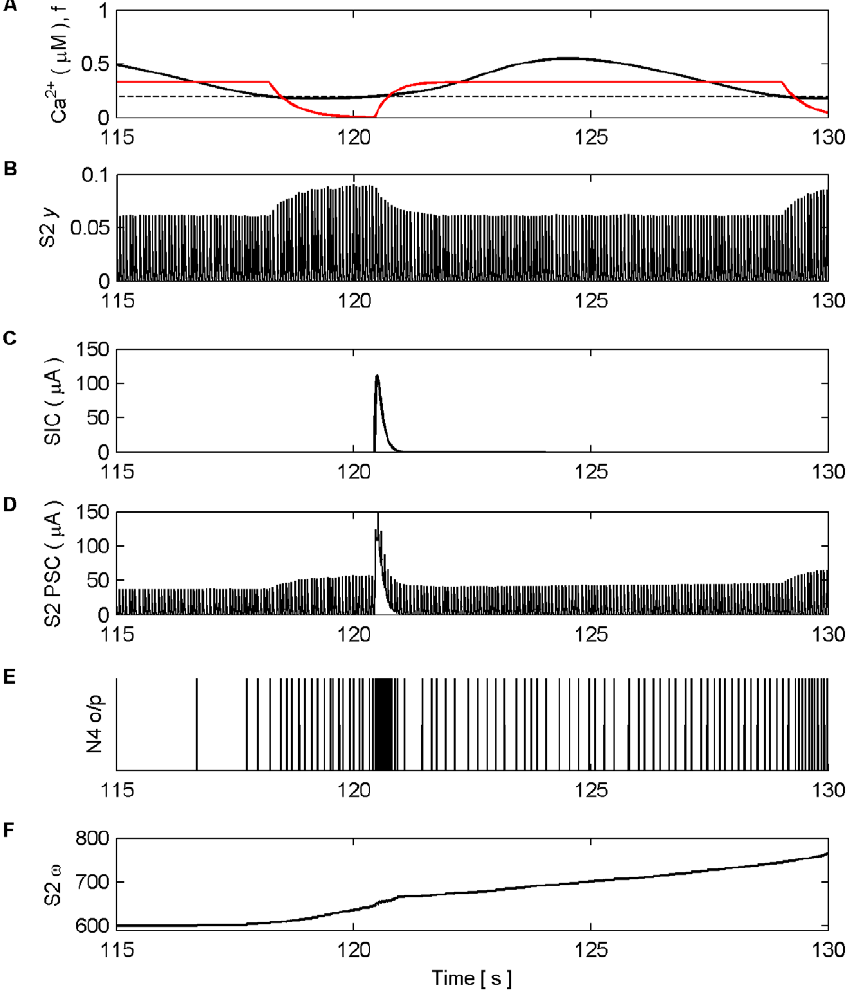
Figure 7. Synaptic Plasticity in the AN Model (last 15 s). (A) Ca 2 + oscillation resulting from pre-synaptic stimulation of S1 by N1, including the gating function f (red) and Ca 2 + threshold (dashed). (B) neurotransmitter ( y ) released by S2 as a result of presynaptic stimulation by N2. Again note how the amplitude of y is modulated by f . (C) SIC induced by the release of glutamate from the astrocyte when Ca 2 + levels cross the Ca 2 + threshold at , 120.4 s. The kinetics of this SIC are similar to those observed in CA1 neurons [21]. (D) PSCs at S2, comprising EPSCs elicited by the neurotransmitter released by N2 and the SIC. (E) N4 output firing activity. (F) Synaptic weight ( v ). At , 115 s the synapse is strong enough to cause firing as a result of the presynaptic activity of N3 without the aid of NMDA induced SICs.